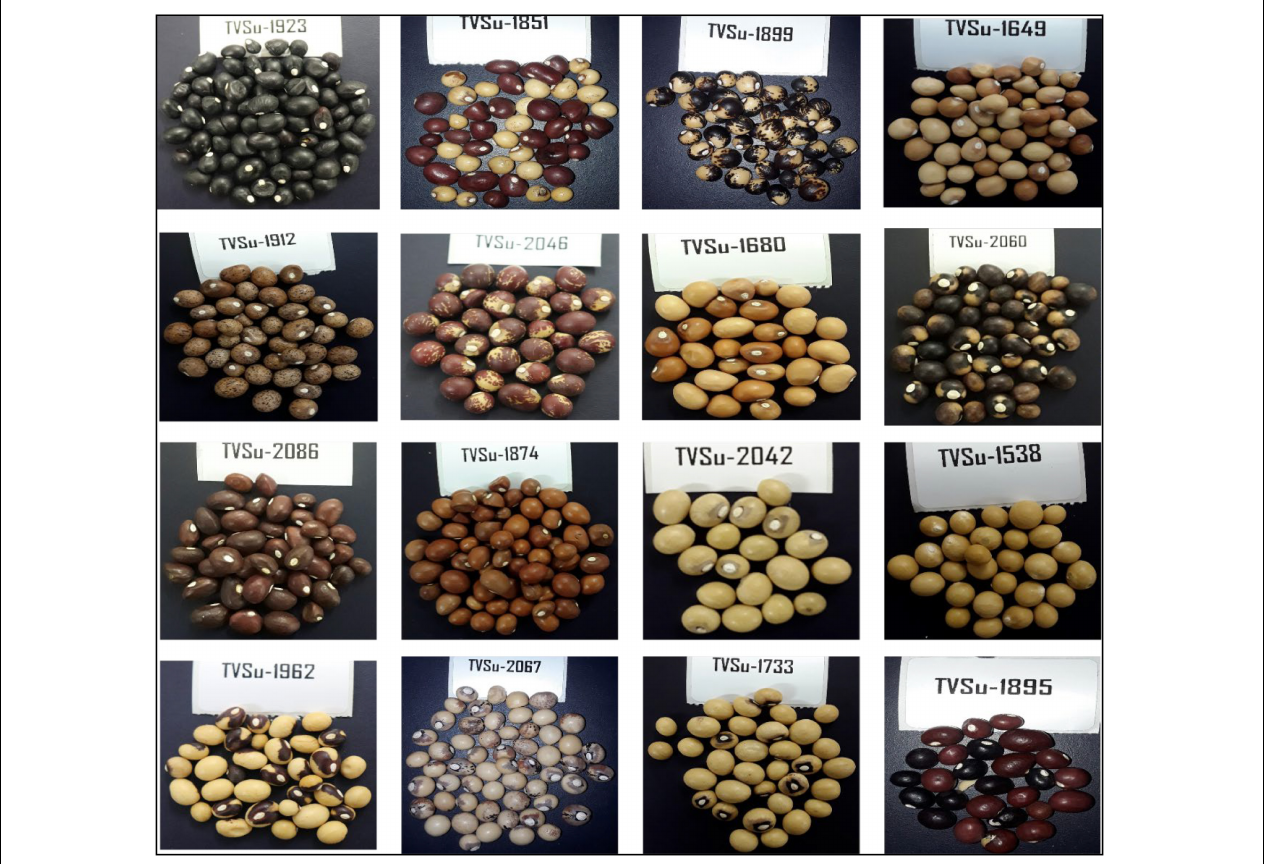
FIGURE 2 | Bambara groundnut seeds showing variability in different accessions through colors, shapes, and eye